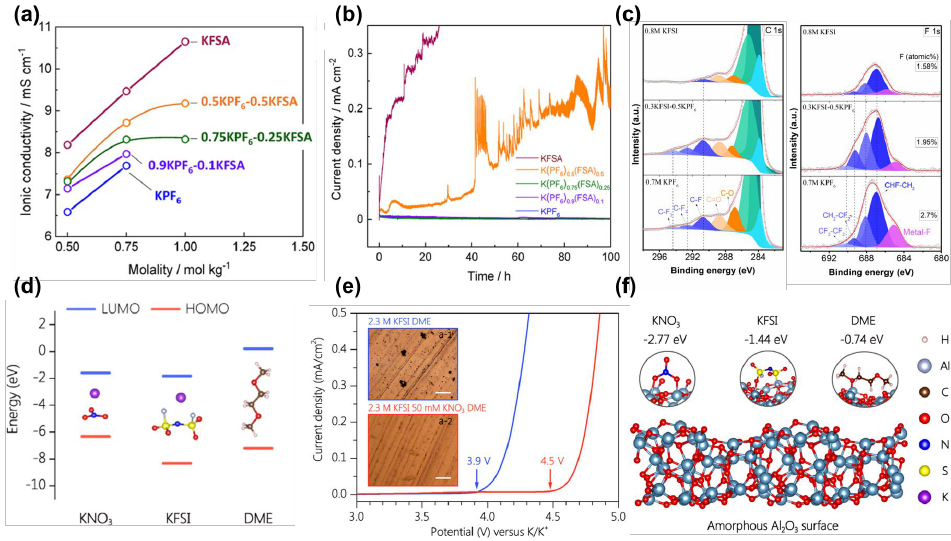
Figure 5. ( a ) Ionic conductivities of binary x KPF 6 − y KFSI/EC − DEC electrolytes with different KPF 6 / KFSI ratios and total molarities; ( b ) chronoamperograms of Al electrodes in x KPF 6 − y KFSI/EC − DEC electrolytes at 4.6 V. Reprinted with permission from Ref. [49]. Copyright 2020, American Chemical Society. ( c ) C 1 s and F 1 s surface XPS profiles of graphite electrodes cycled with 0.8 M KFSI, 0.5 KPF 6 − 0.3 KFSI and 0.7 M KPF 6 . Reprinted with permission from Ref. [28]. Copyright 2021, Elsevier. ( d ) LUMO and HOMO of KNO 3 , KFSI and DME (Atoms in